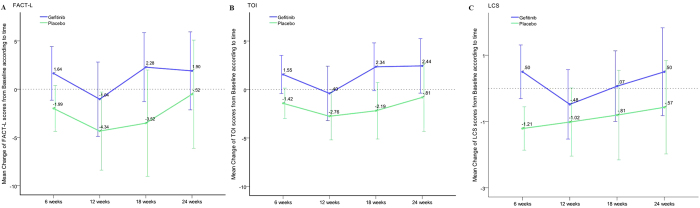
Mean change of quality of life (QoL) from baseline to 24 weeks in gefitinib and placebo arms(A: FACT-L scores; B: TOI scores; C: LCS scores). The QoL changes from baseline were calculated by each arm every 6 weeks until less than 10% of patients had available data. The gefitinib arm always performed better than the placebo arm in FACT-L, TOI and LCS during the cause of treatment.